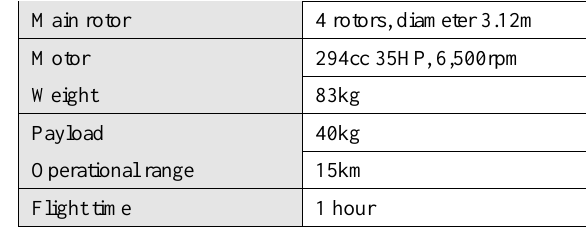
Figure 2. Unmanned Helicopter (Shark-120)